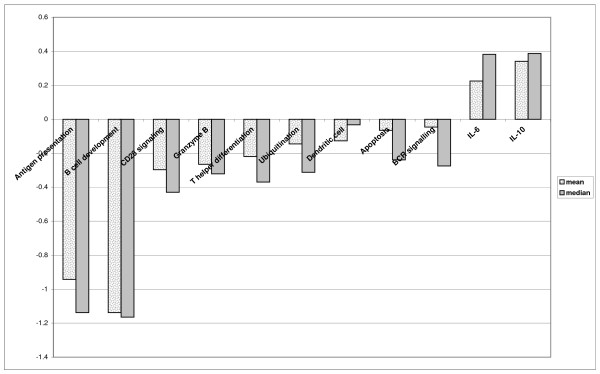
Histogram depicting the mean and median of the differences in gene expression levels between MV-NMV by intracellular signaling pathways. (< 0) means that expression in MV < expression in NMV; (> 0) means that expression in MV > expression in NMV).